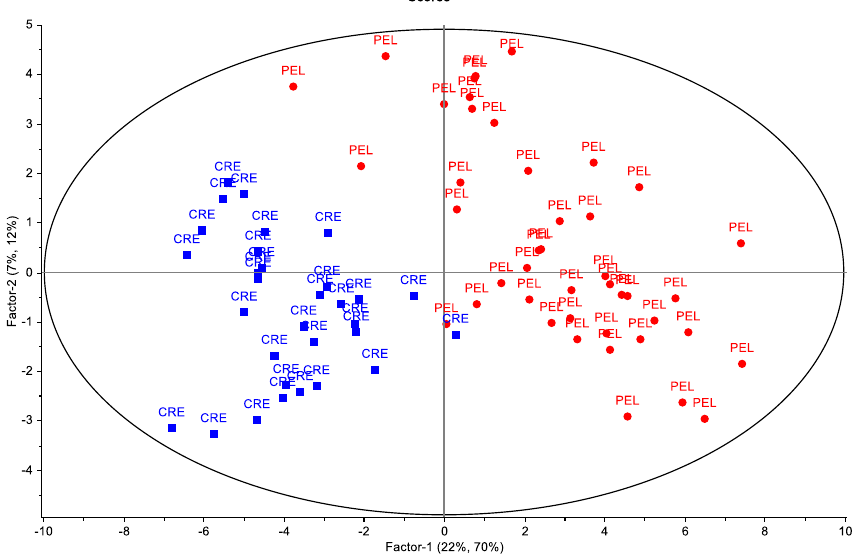
Figure 4. Multivariate analysis of EVOO samples of Koroneiki cultivar from the Peloponnese (PEL) and Crete (CRE). PLS − DA scores plot (red dots—PEL; blue squares—CRE). The ellipse represents and Crete (CRE). PLS − DA scores plot (red dots — PEL; blue squares — CRE). The ellipse represents the Hotelling’s T2 critical the Hotelling’s T2 critic al limit.